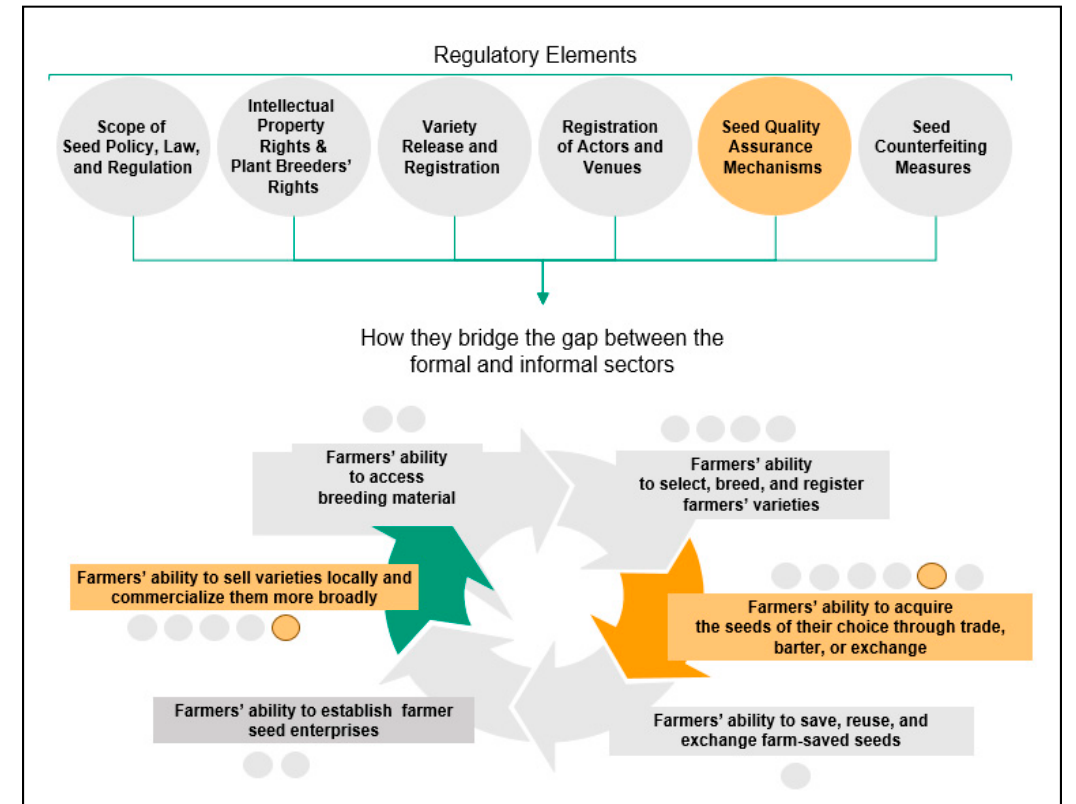
Figure 4. Liberalizing seed quality control mechanisms (adapted from [2,9]).